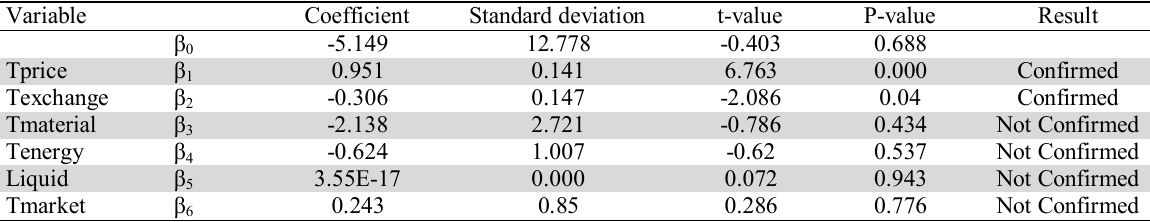
The summary of regression analysis